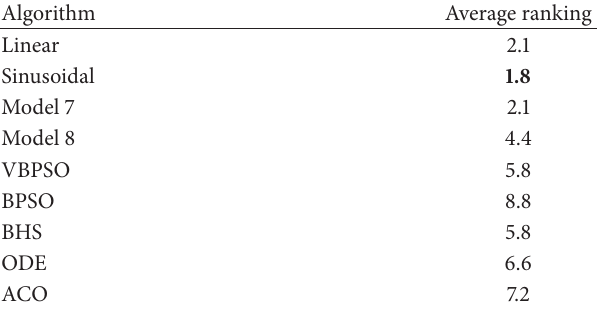
Figure 10: Best obtained 1000-element planar array (a) 3D radiation pattern of the (b) far-field patterns at 𝜙 = 0 ∘ and 𝜙 = 90 ∘ planes. Table 8: Average algorithm rankings obtained by Friedman